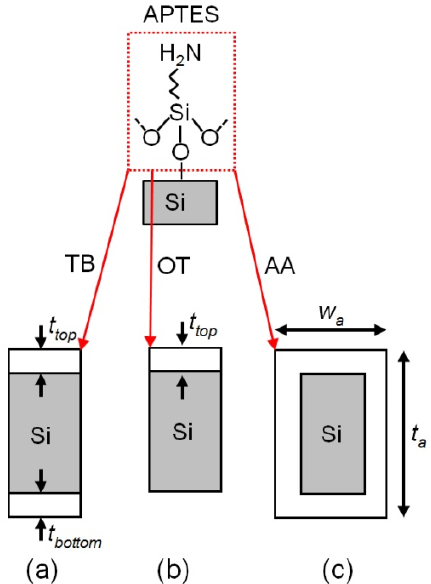
Figure 5. The schematic of the functionalized silicon surface with Amino-propyltrimethoxysilane (APTES) in different coating configurations: ( a ) top and bottom (TB), ( b ) only top (OT), and ( c ) all-around